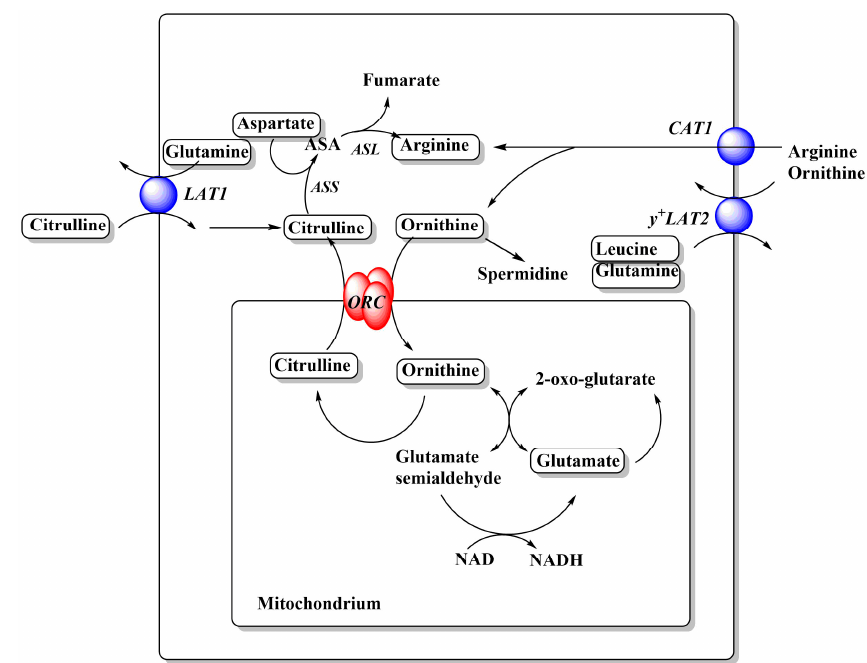
Figure 3. Relationships between cationic amino acid transporters and metabolism. Arginine and ornithine metabolism in cancer cells. A full urea cycle is not expressed in cancer cells. Amino acids are depicted in rounded frames. Transporters that feed into these pathways are depicted as blue spheres and their names are shown in italics. For more detailed depictions of transport mechanism, see Figure 2. Abbreviations: ASS, arginine succinate synthetase; ASA, argininosuccinate; ASL,